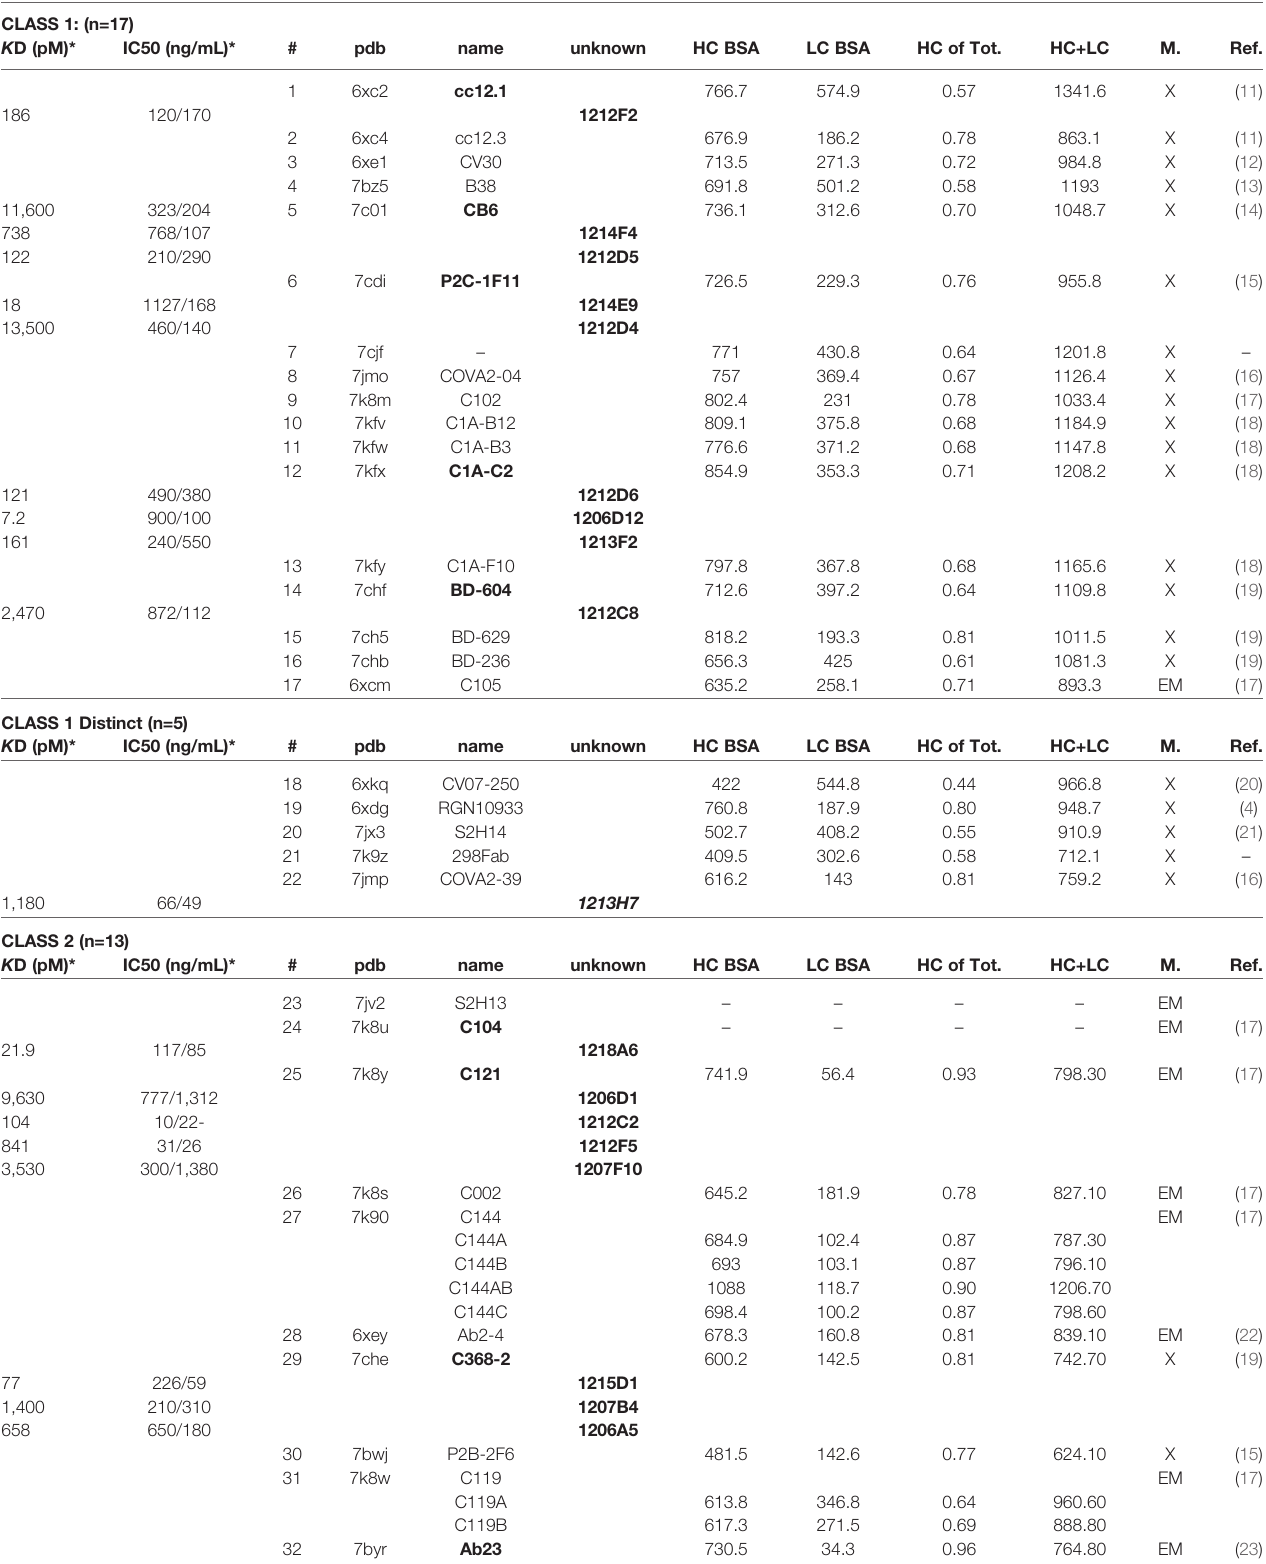
TABLE 1 | Assignment of Structurally Uncharacterized NAbs (unknown) to NAb-RBD Structures in the